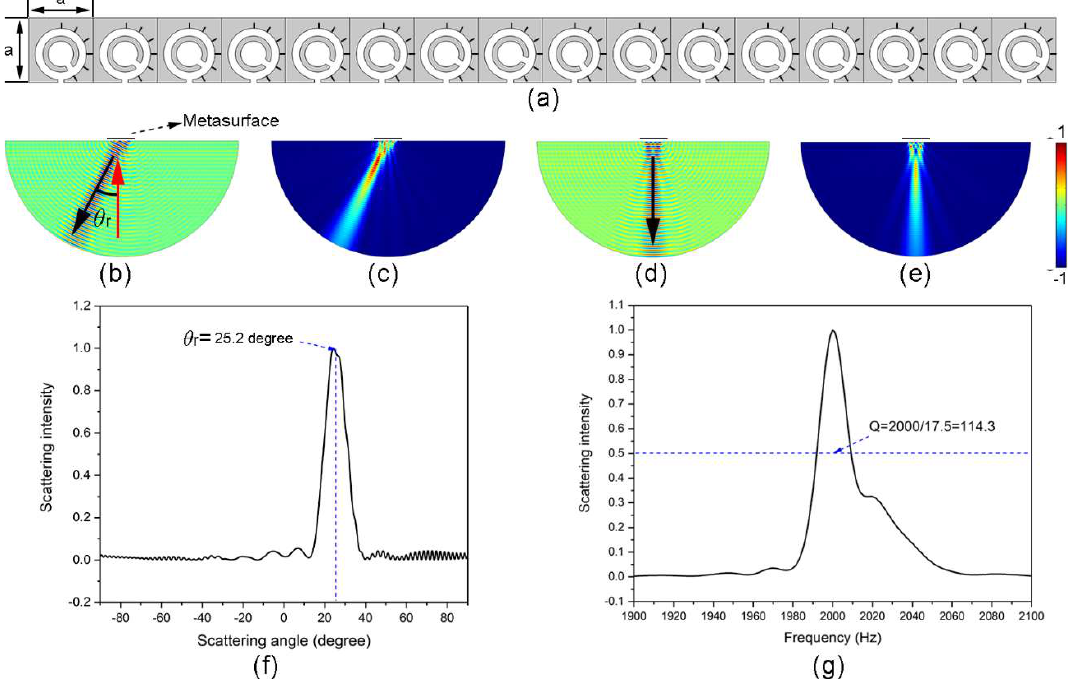
Figure 3. Acoustic metasurface for high-Q spectrum splitting. ( a ) Schematic sketch of the constructed metasurface, which consists of 16 microunits. All the microunits are squares with the same side lengths. The phase gradient interval of adjacent microunits is 45°. The grey areas are acoustic rigid materials, and the white areas are filled with air medium. ( b ) Normalised transient sound pressure field distribution of reflected waves at 2000 Hz. The red and black arrows indicate the propagation directions of incident and reflected waves, separately. ( c ) Normalised squared absolute pressure distribution of reflected waves at 2000 Hz. ( d ) and ( e ) Normalised transient sound pressure and squared absolute pressure field distributions of reflected waves at 1980 Hz for comparison. ( f ) Normalised scattering field intensity of sound wave versus scattering angle at 2000 Hz. ( g ) Normalised scattering field intensity of sound wave of the scattering angle of 25.2° as a function of frequency.